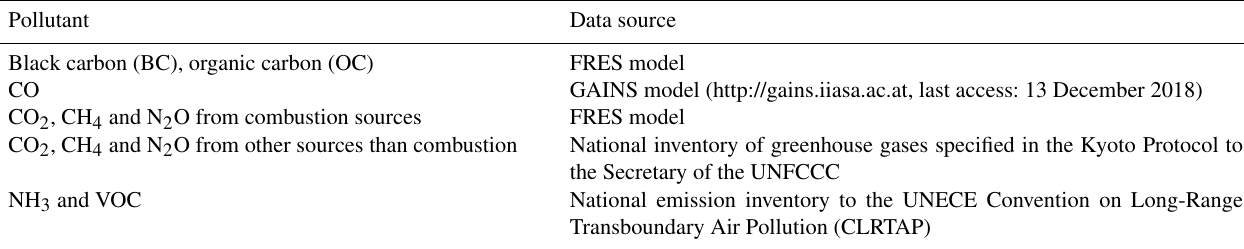
Table 1. Data sources of the historical emission data for 2000–2010.